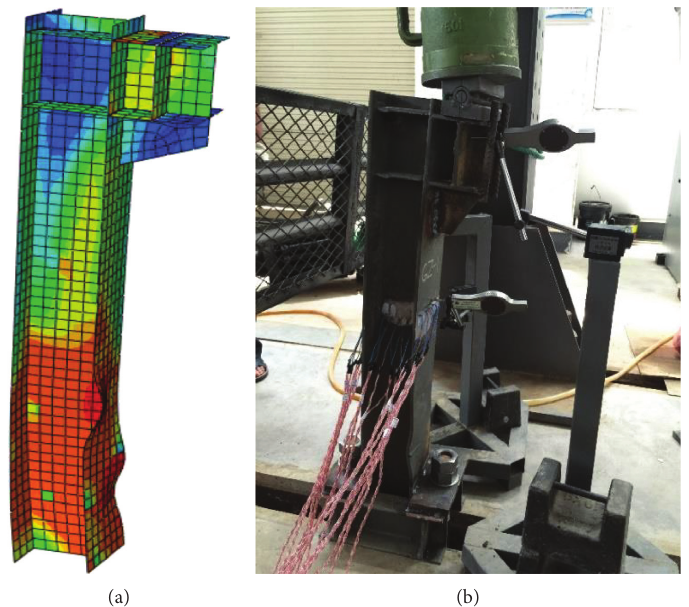
Figure 16: Comparison of failure mode. (a) Failure mode of finite element model. (b) Failure mode of the specimen.